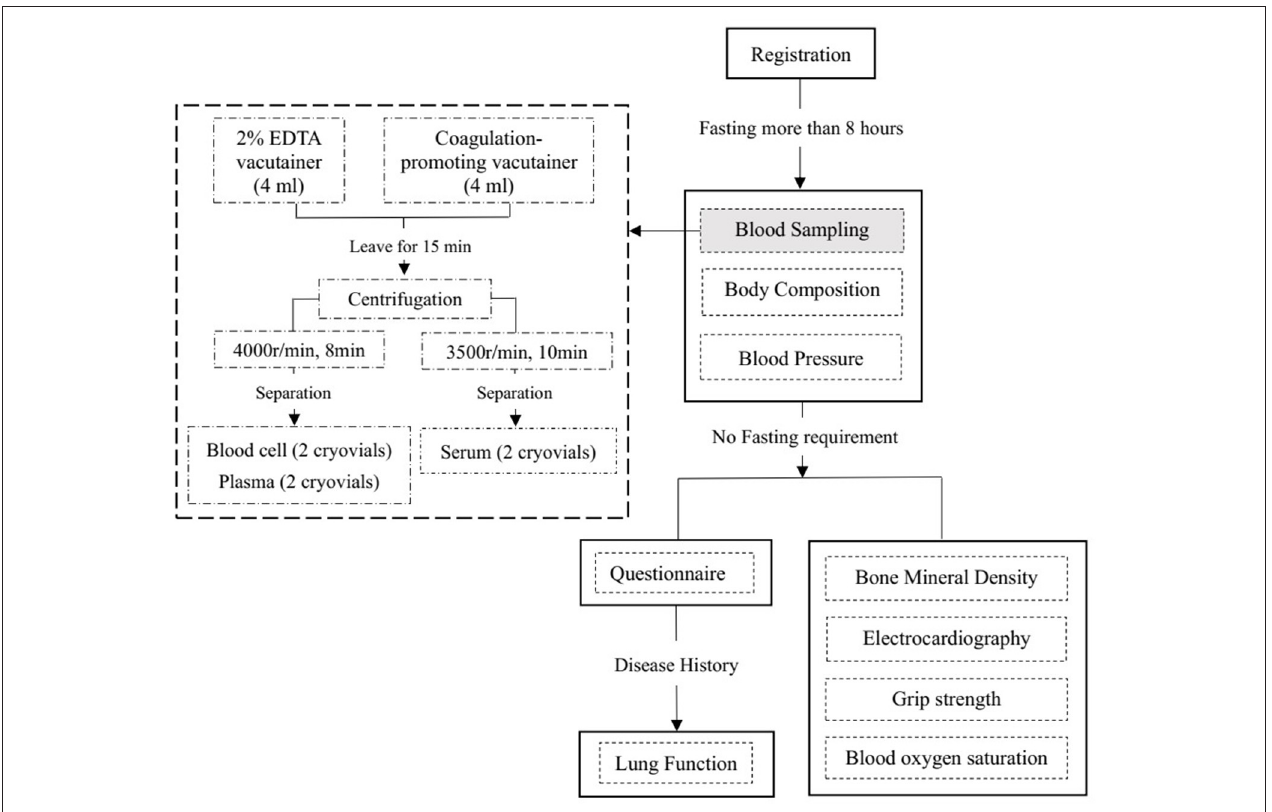
FIGURE 3 | Flowchart of the baseline survey in